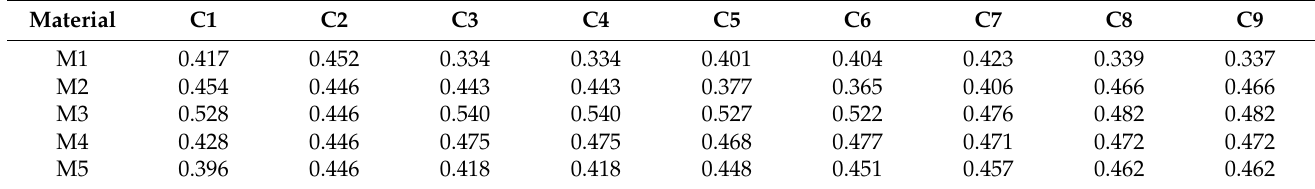
Table 11. TOPSIS normalized